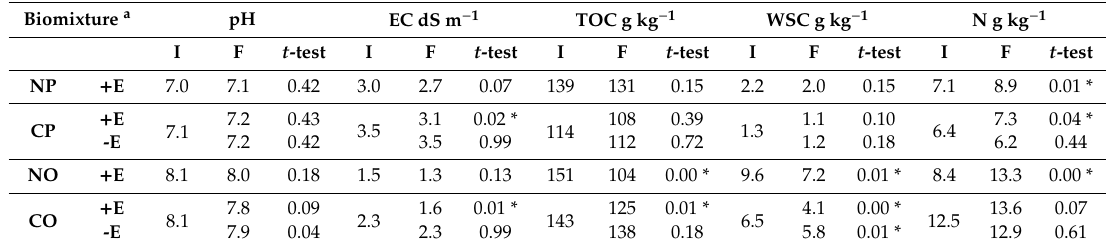
Table 2. Chemical analysis of the biomixtures at initial (I) and final (F) times. Biomixture